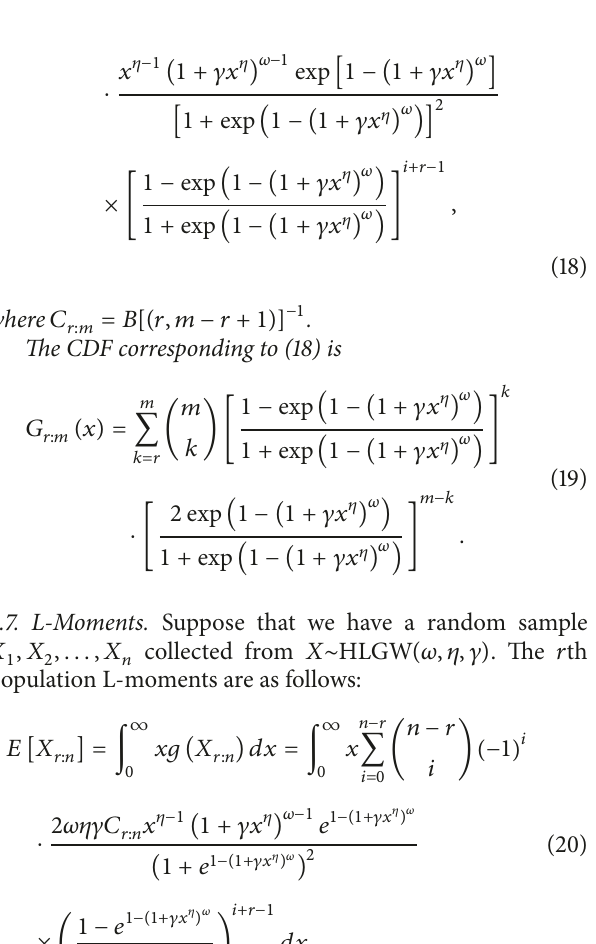
Figure 2: The HRF of HLGW distribution for different parameter